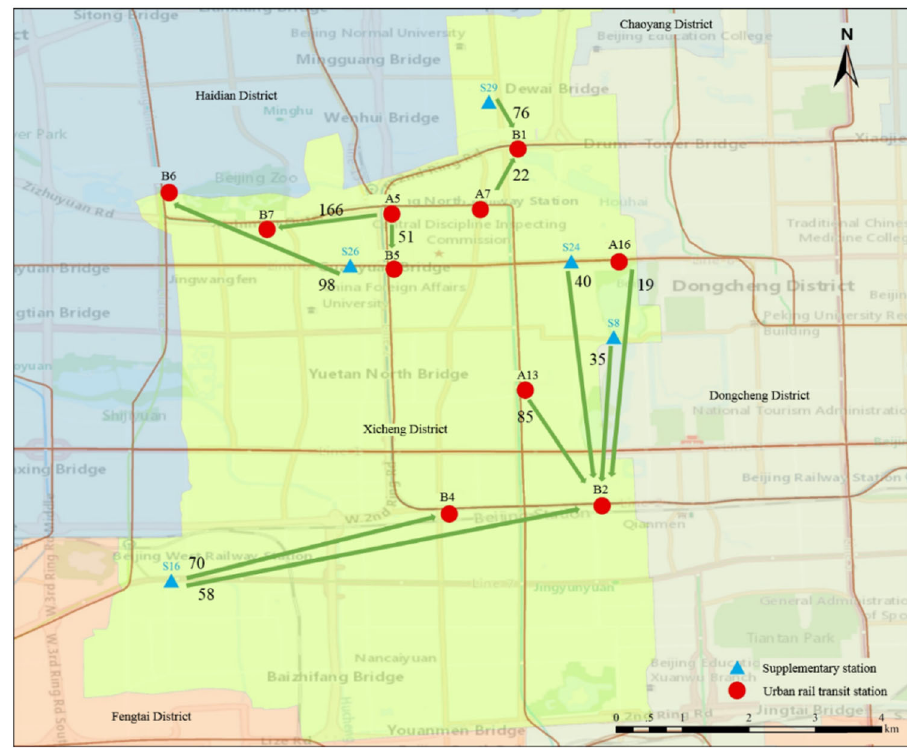
Fig. 10 Deployment schematic diagram of import